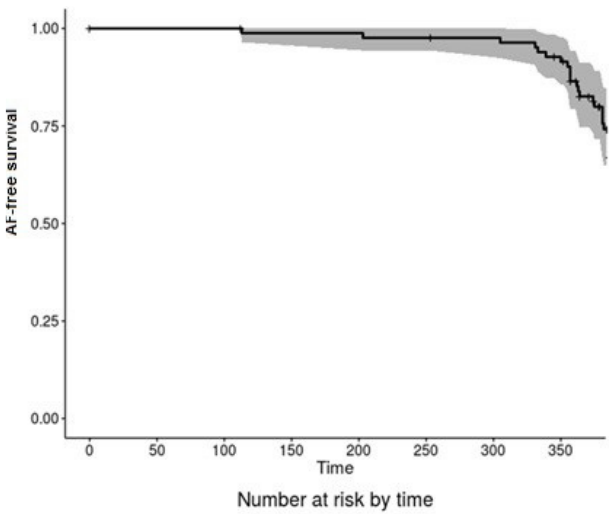
Fig. 7 - Actuarial curve for AF-free survival.